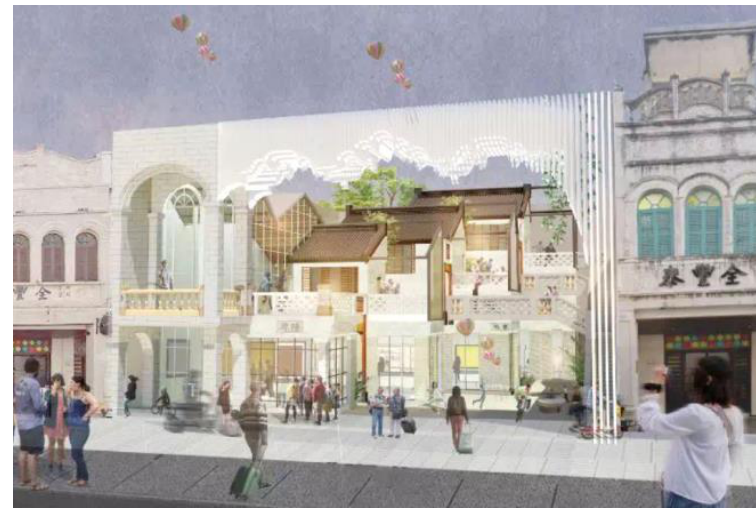
Figure 19. Interface modification (source: